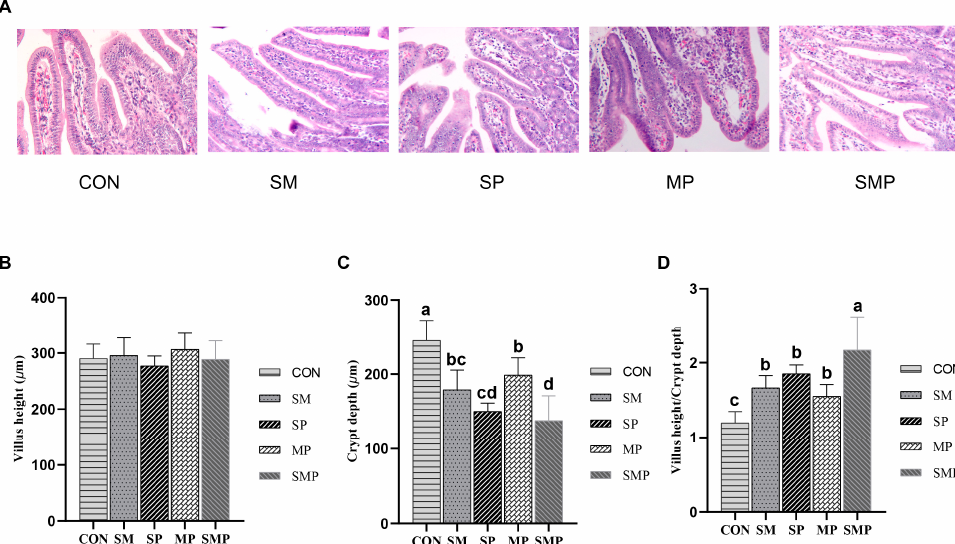
Figure 1. Effects of supplementing the diets with different combinations of SB, MCFAs, and omega − 3 PUFA on the intestinal morphology in suckling piglets. Intestinal morphology of the jejunum was shown ( A ) among the five groups. Villous height ( B ), crypt depth ( C ), and villus height/crypt depth ( D ) in the jejunum (shooting magnification of 400×). Data are presented as means ± SEM ( n = 6). a–d Values within a row with different superscripts differ significantly at p < 0.05.